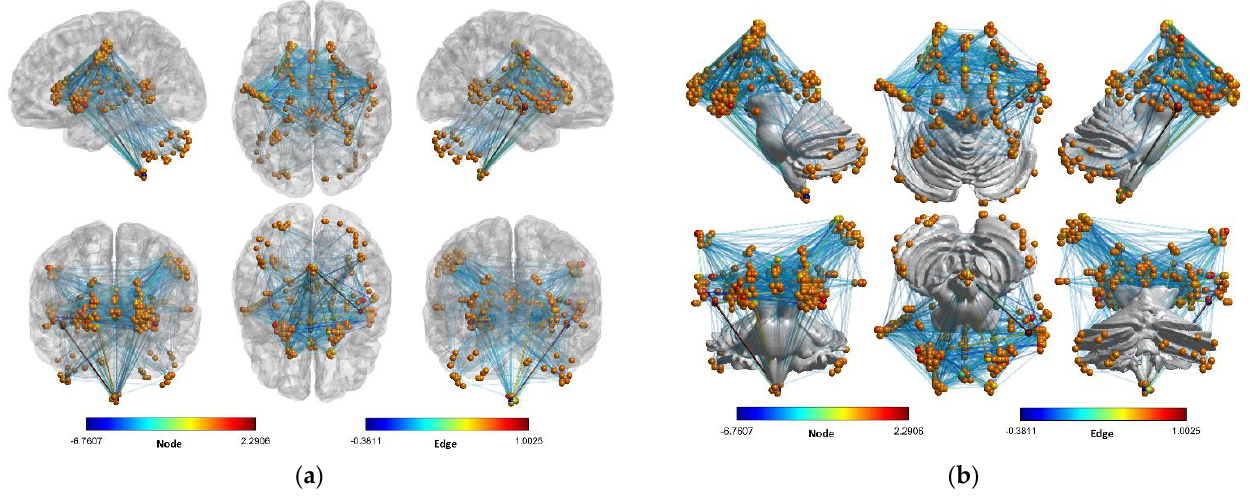
Figure 9. Voxel-based network for the subject aged 63. Edges indicate the effect of interactions between voxels on age. If the interaction between two nodes contributes significantly to age, there is an edge between the nodes. The colors of nodes and edges represent the strength of the contribution, respectively, where positive or negative values signify the direction of the contribution. ( a ) Network with a brain as reference, ( b ) network with cerebellum as reference. The graphs were visualized with BrainNet Viewer [42].